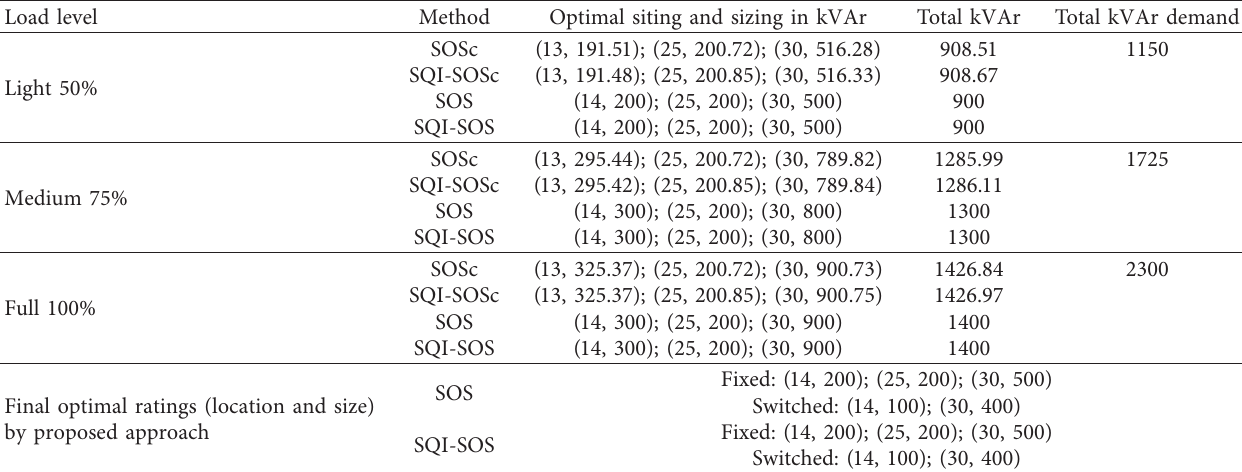
Table 4: Optimal siting and sizing of capacitors for the 33-bus system with the CP load model at different load levels.